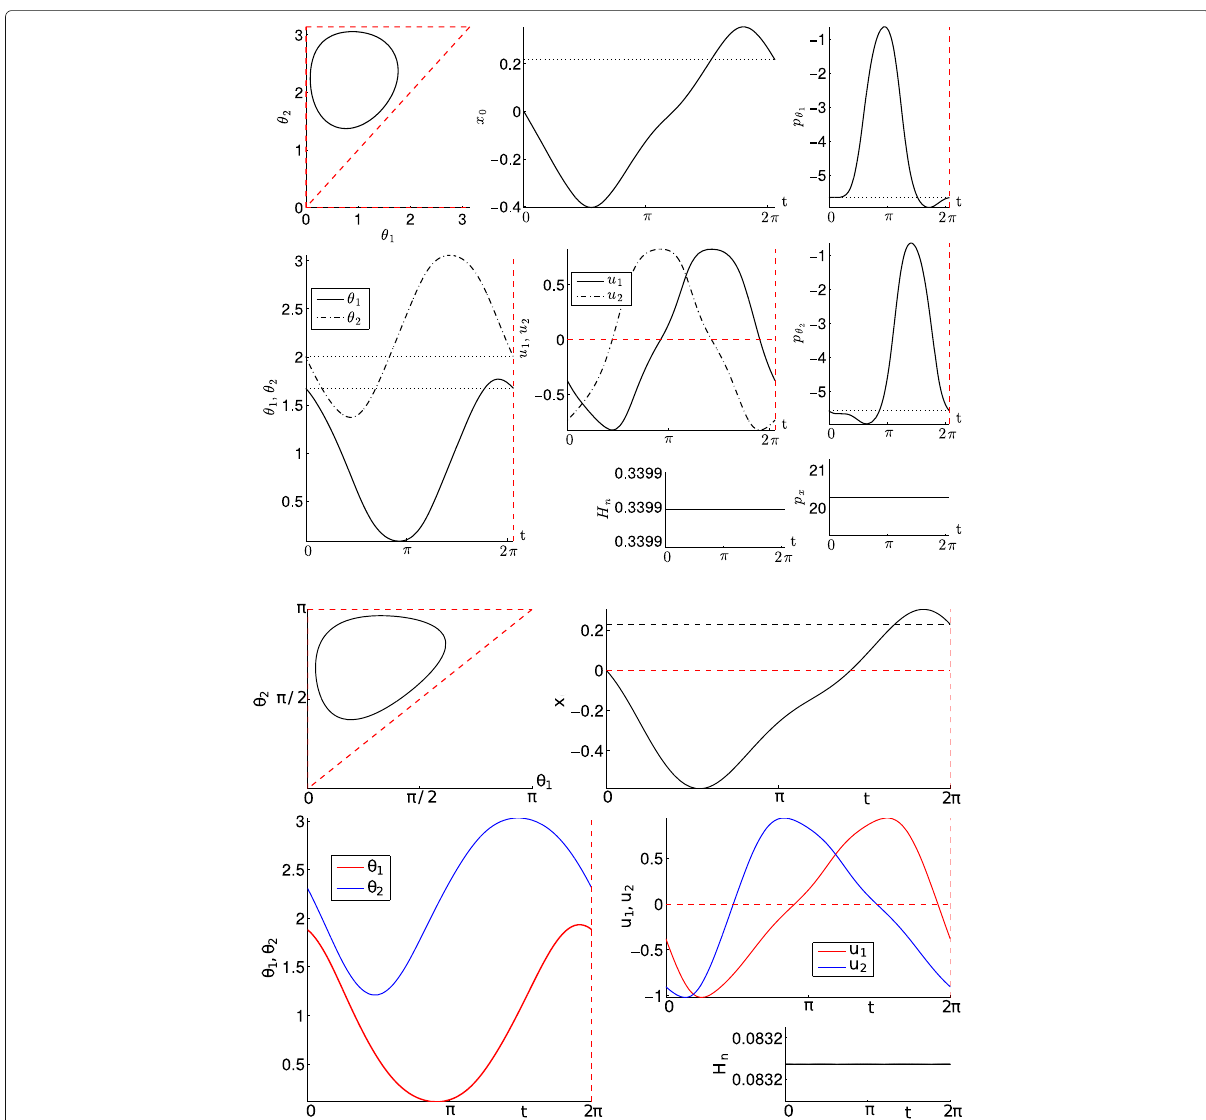
Fig. 14 Optimal stroke of the Copepod swimmer for the Euclidean cost (top) and the mechanical energy (bottom), obtained by the transversality conditions of the maximum